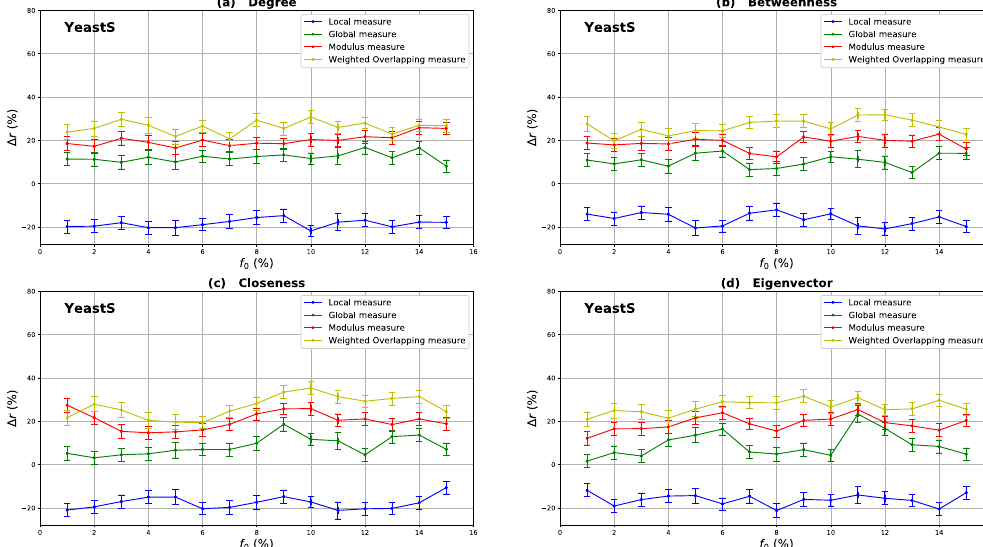
Figure 18. The relative difference of the outbreak size Δ r as a function of the fraction of initial spreaders f 0 . The Degree ( a ), Betweenness ( b ), Closeness ( c ) and Eigenvector ( d ) centrality measures derived from the Overlapping Modular centrality are compared to the standard counterpart designed for networks with no community structure. A real-world network (YeastS) with weak community structure is used. The estimated value of its mixing coefficient is equal to